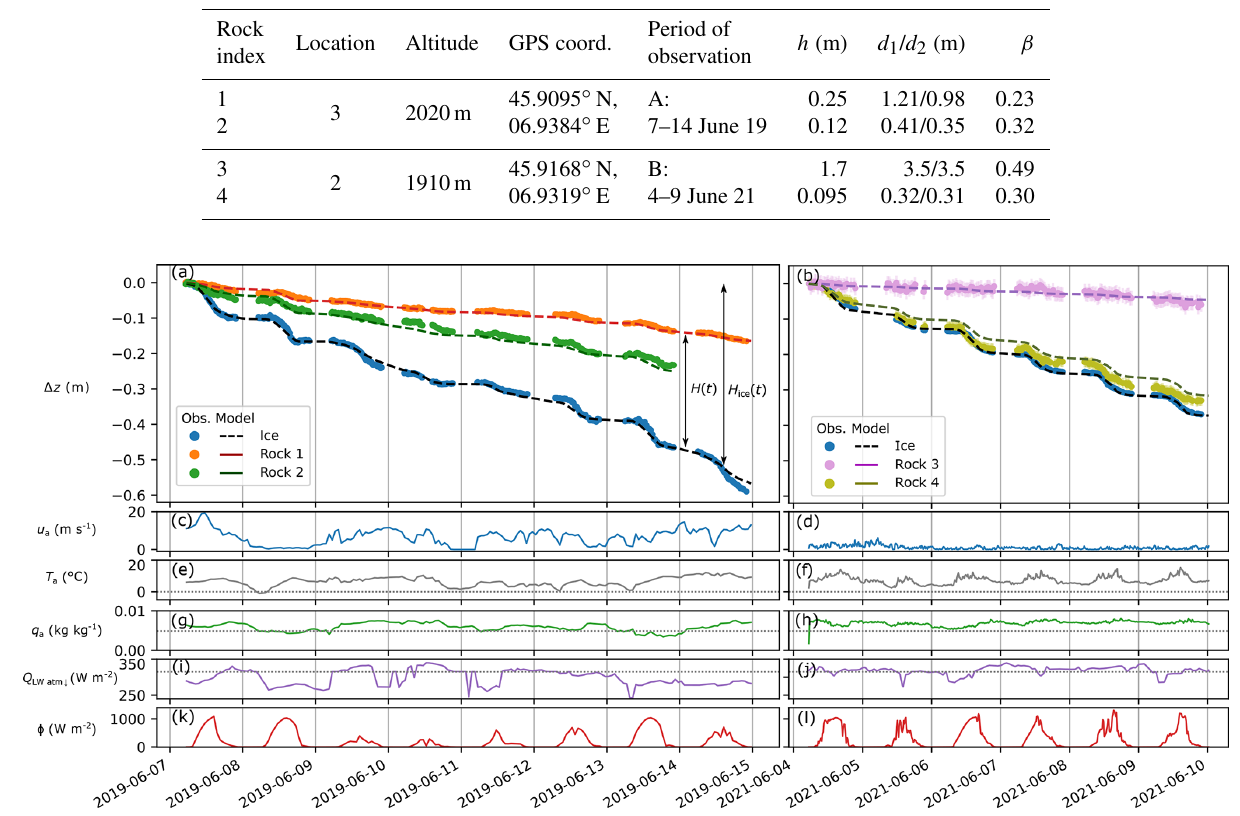
Figure 4. (a, b) Vertical position of the ice surface (blue markers) and of rocks 1 to 4 (coloured markers; see Table 1). The dashed black line corresponds to the model for ice ablation (see Sect. 3.1). The coloured solid lines correspond to the model for rocks (see Sect. 3.2). These models use meteorological data measured at the Requin AWS as input: wind speed u a (c, d) , air temperature T a (e, f) , air specific humidity q a (g, h) and solar radiation (cid:56) (k, l) as well as the long-wave radiation coming from the atmosphere Q LW atm ↓ obtained from the S2M reanalysis (i, j) . The dotted lines correspond to the ice surface values. The date format is